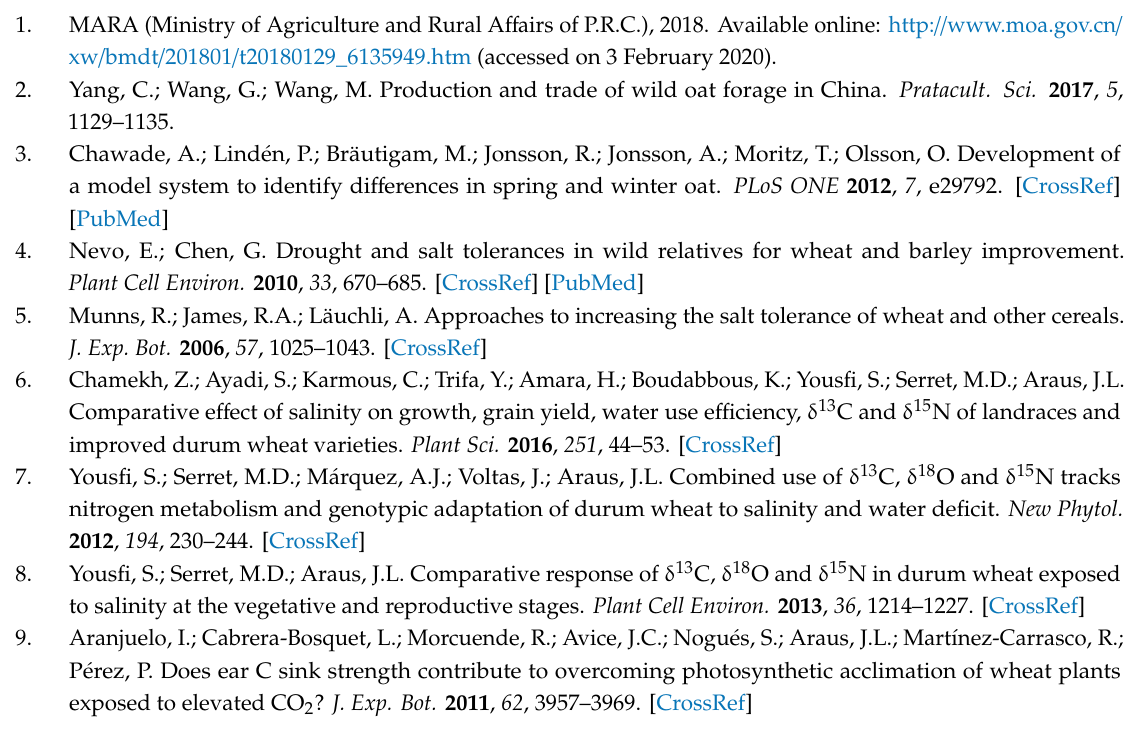
Table S1: E ff ect of di ff erent levels of salinity on the plant biomass, photosynthetic traits (P n , g s , E, WUE i ), carbon isotope composition ( δ 13 C shoot ), leaf chlorophyll content (Chl), nitrate reductase activity (NR) and glutamine synthetase activity (GS) of six di ff erent forage-type oat ( Avena sativa L.) genotypes. The data shown are the means of three replicates for each genotype in each treatment. Means followed by di ff erent letters are significantly di ff erent ( p < 0.05). Table S2: E ff ect of di ff erent levels of salinity on the ion concentration (P shoot , K + / Na + shoot , Ca 2 + / Na + shoot , Mg 2 + root , Ca 2 + / Na + root ) of shoots and roots of six di ff erent forage-type oat ( Avena sativa L.) genotypes. The data shown are the means of three replicates for each genotype in each treatment. Means followed by di ff erent letters are significantly di ff erent ( p <